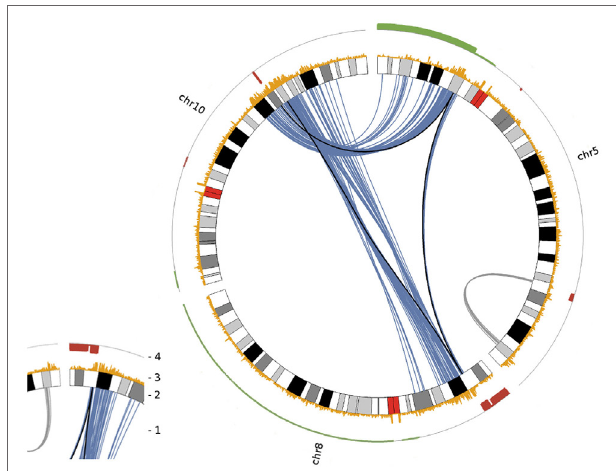
FigUre 5 | Circos plot visualizing chained translocations between chromosomes 5, 8 and 10. In this Circos plot chromosomes are radially aligned. Arcs within this circle indicate significant interchromosomal and long distance intrachromosomal interactions. Following the numbering given in the small insert to the left: (1) significant interchromosomal interactions (blue lines; FDR < 0.001), significant long distance intrachromosomal interactions (gray lines; > 25 Mb, FDR < 0.001) and translocations as given in Table 1 (black lines); (2) radially aligned chromosome ideograms; (3) count of significant interactions per 50 kb bin (all interaction distances; max = 10); (4) DNA copy number status in red (deletion) and green (gain) as detected by array comparative genomic